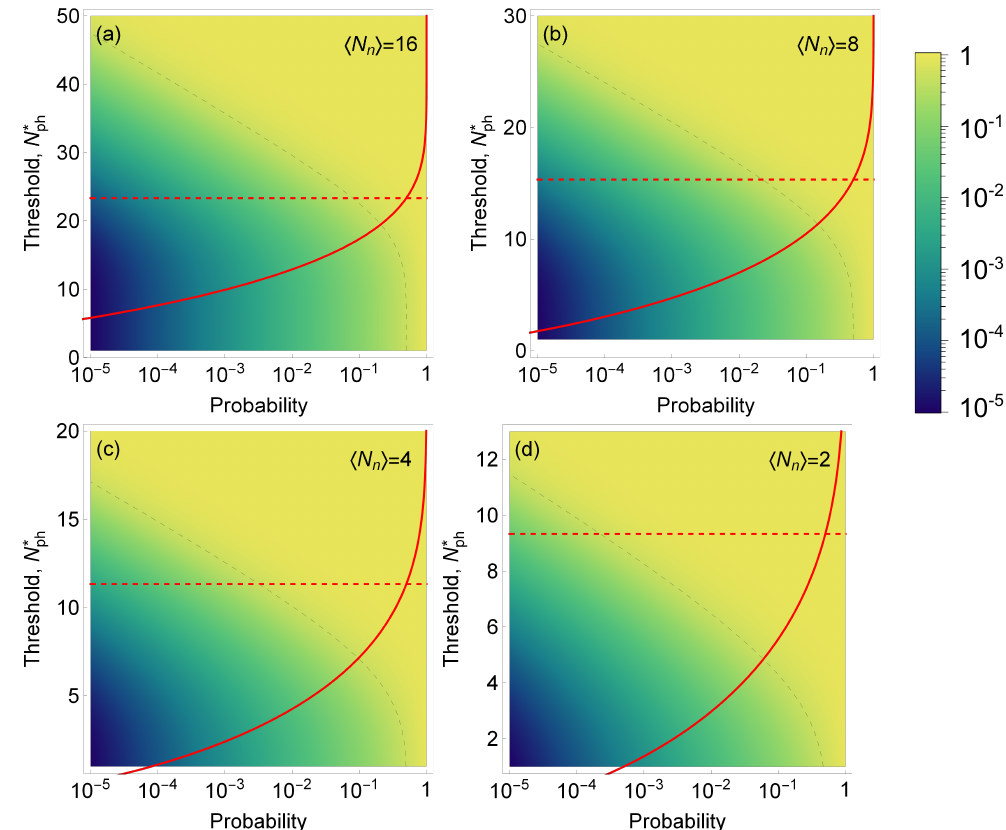
Figure 4. Color map of the success rate S (i.e., the fraction of time when the volume identified as containing a single emitter indeed contains a single emitter) as a function of the probability of encountering a single emitter in a sample (horizontal axis) and the threshold for number of photons detected (left vertical axis). Dashed gray line is the isoline for a success rate of 50%. Red line: the probability F of erroneously discarding trials containing a biomarker as function of the threshold ) = 50%. We assume a fixed signal intensity level N ∗ ; dashed red line shows N ∗ for which F ( N ∗ ph ph ph (cid:104) N (cid:105) = 8 (photons per trial) and noise intensities (cid:104) N n (cid:105) = { 16,8,4,2 } in ( a – d ), respectively. Note, that b even though the density plot and red curves are shown on the same plot, the horizontal axes have different meaning for F and S